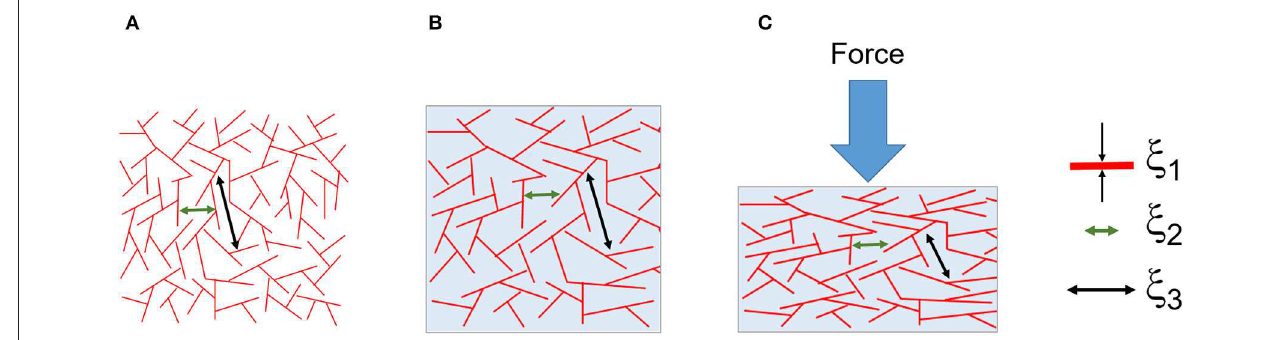
FIGURE 12 | Composite illustration of the results from the tomographic analysis and mechanics. (A) The dry foam with a distribution of three correlation lengths ξ 1 , ξ 2 , and ξ 3 . The correlation lengths were assigned to the silk thickness (at around 4 µ m), the small pores (between 10 and 20 µ m) and the large pores (between 50 and 130 µ m), respectively. (B) The wet and swollen scaffold. (C) The compressed scaffold and the collapse of the larger pores ( ξ 3